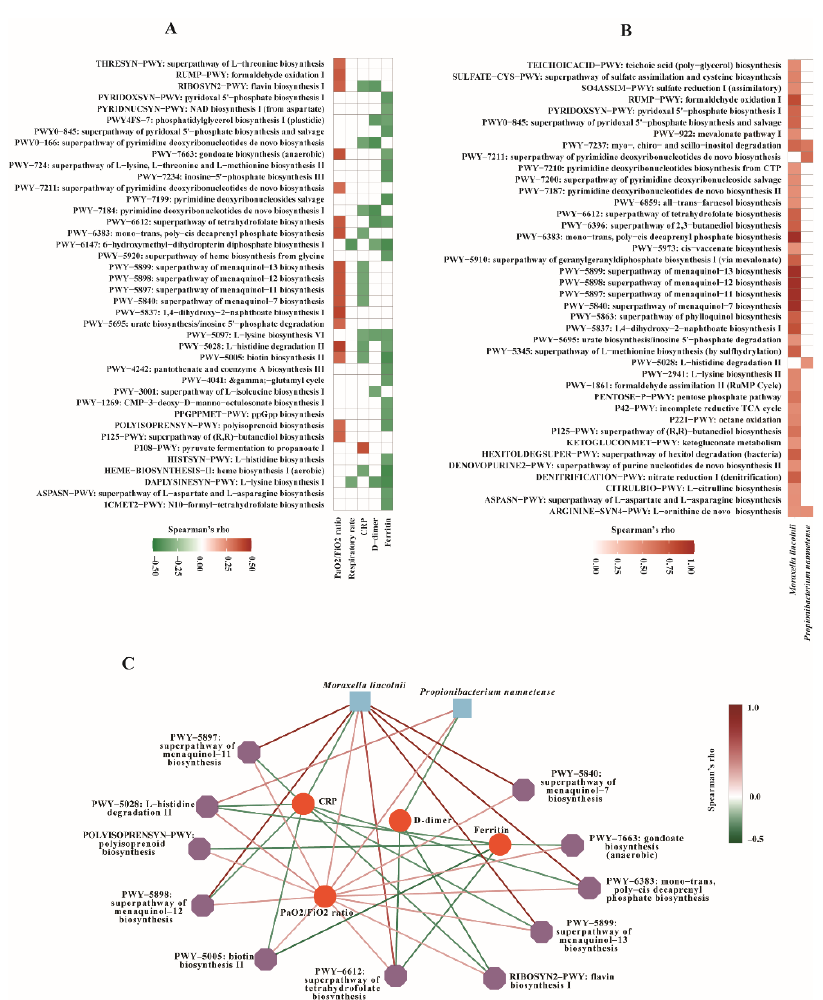
Figure 4. Correlation analysis. Correlations between ( A ) metabolic pathways and clinical markers, ( B ) metabolic pathways and bacterial species biomarkers associated with better clinical outcome. Spearman’s correlation rho values are represented by color gradient as indicated (red is for positive, green is for negative correlation). Only correlations with p < 0.05 are displayed. ( C ) Correlation network of bacterial species, metabolic pathways, and clinical markers. The nodes are two bacterial species biomarkers (blue squares), metabolic pathways (purple polygons), and clinical markers (red circles). Two nodes are connected if their Spearman’s correlation is significant ( p < 0.05). The edge color indicates correlation between subjects (red: positive, green: negative). Spearman’s correlation rho values are represented by color gradient as